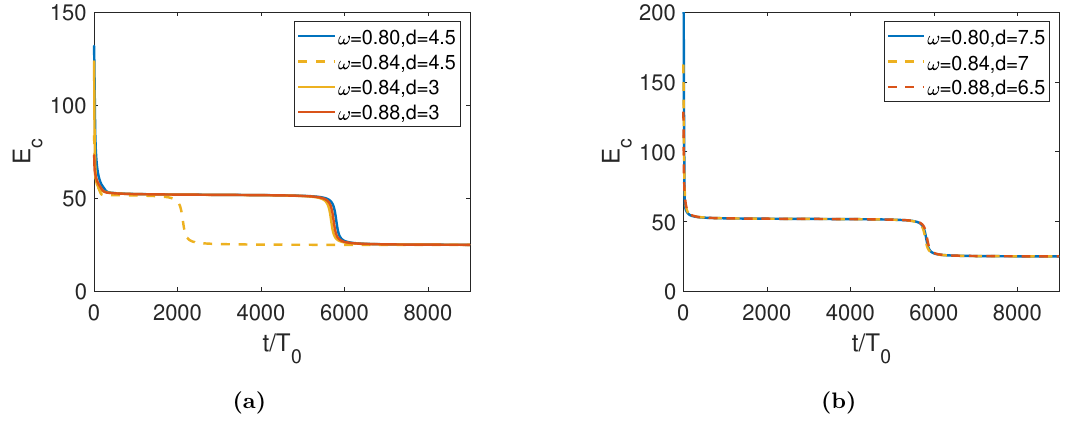
Figure 25. Lifetimes of quadrupole (left) and octupole (right) CSQs with different initial ω and d . Lifetimes are shown in units of T 0 = 2 π/m